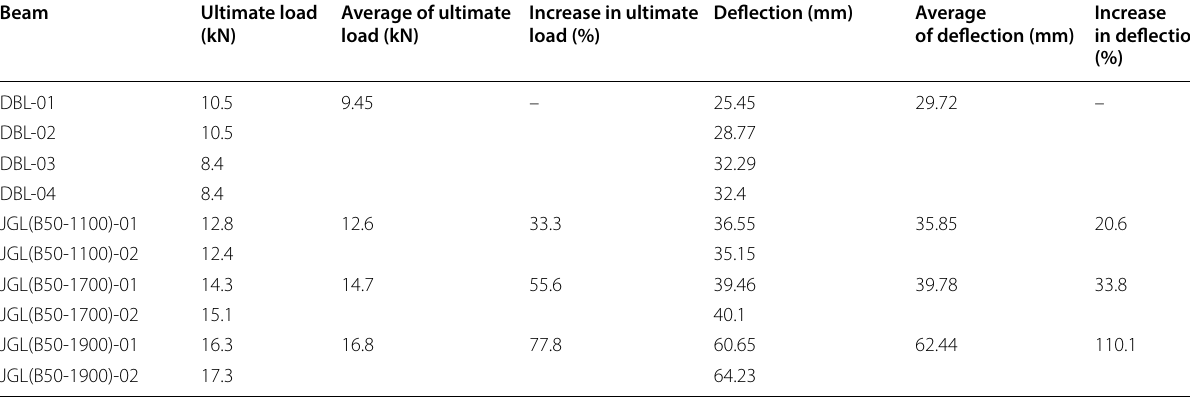
Table 2 Summary of ultimate load and deflection of tested specimens